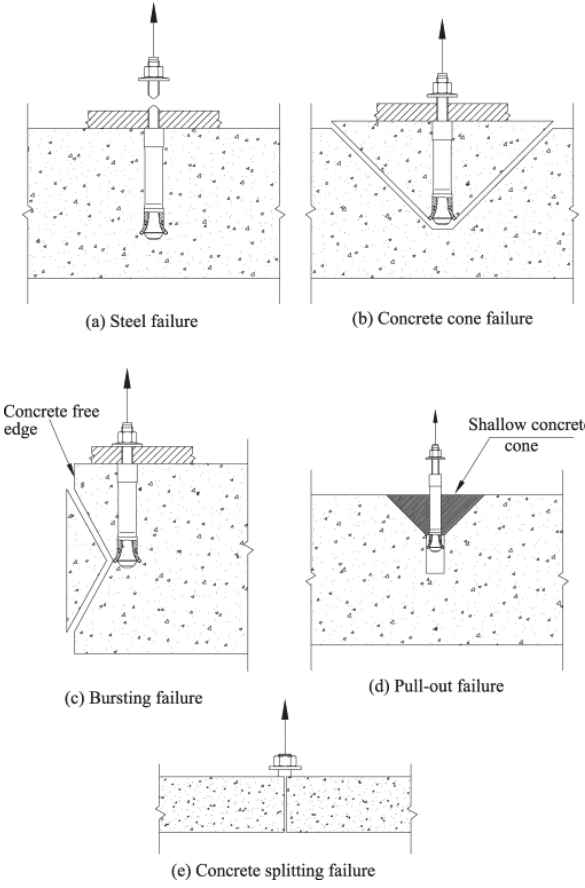
Figure 2: Different failure mechanisms of cast-in and post-installed mechanical anchors